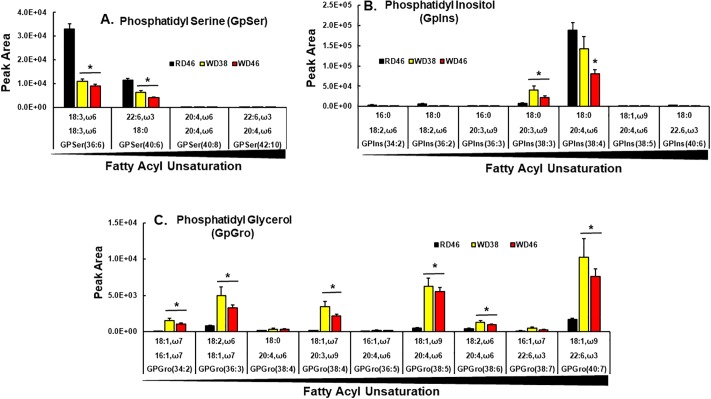
Western diet effects on hepatic phosphatidyl serines (GpSer), phosphatidyl inositols (GpIns) and phosphatidyl glycerols (GpGro).GpSer, GpIns and GpGro were quantified using an un-targeted LC/MS approach (Materials and methods). Results are presented as peak area for GpSer (A), GpIns (B) and GpGro (C), mean ± SEM, N = 7–8 samples; *, FDR <0.05 versus the RD46 group. The results are arranged as increasing fatty acyl unsaturation within specific glycerophospholipids.